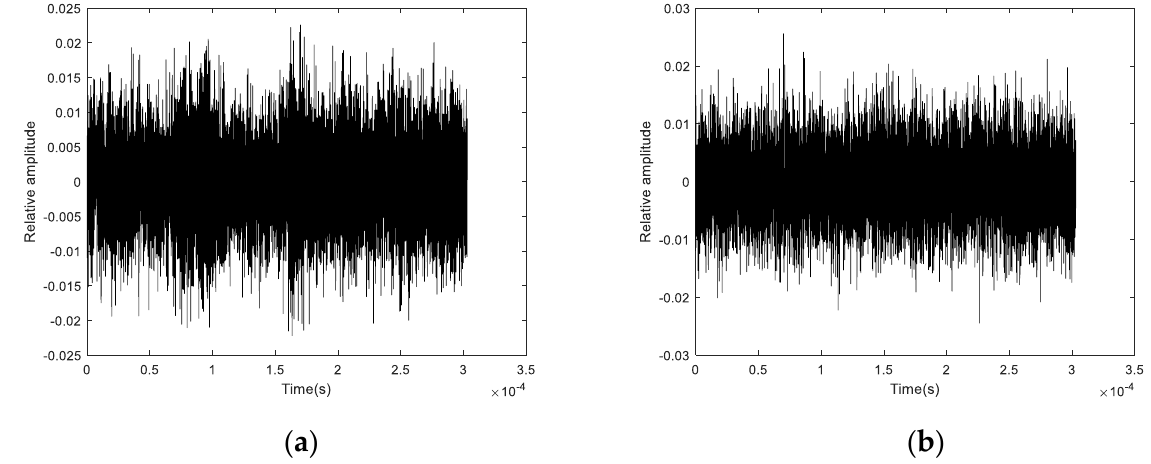
Figure 2. Time domain waveform of the sampled signals. ( a ) The HIFU echo signal; ( b ) the noise signal.